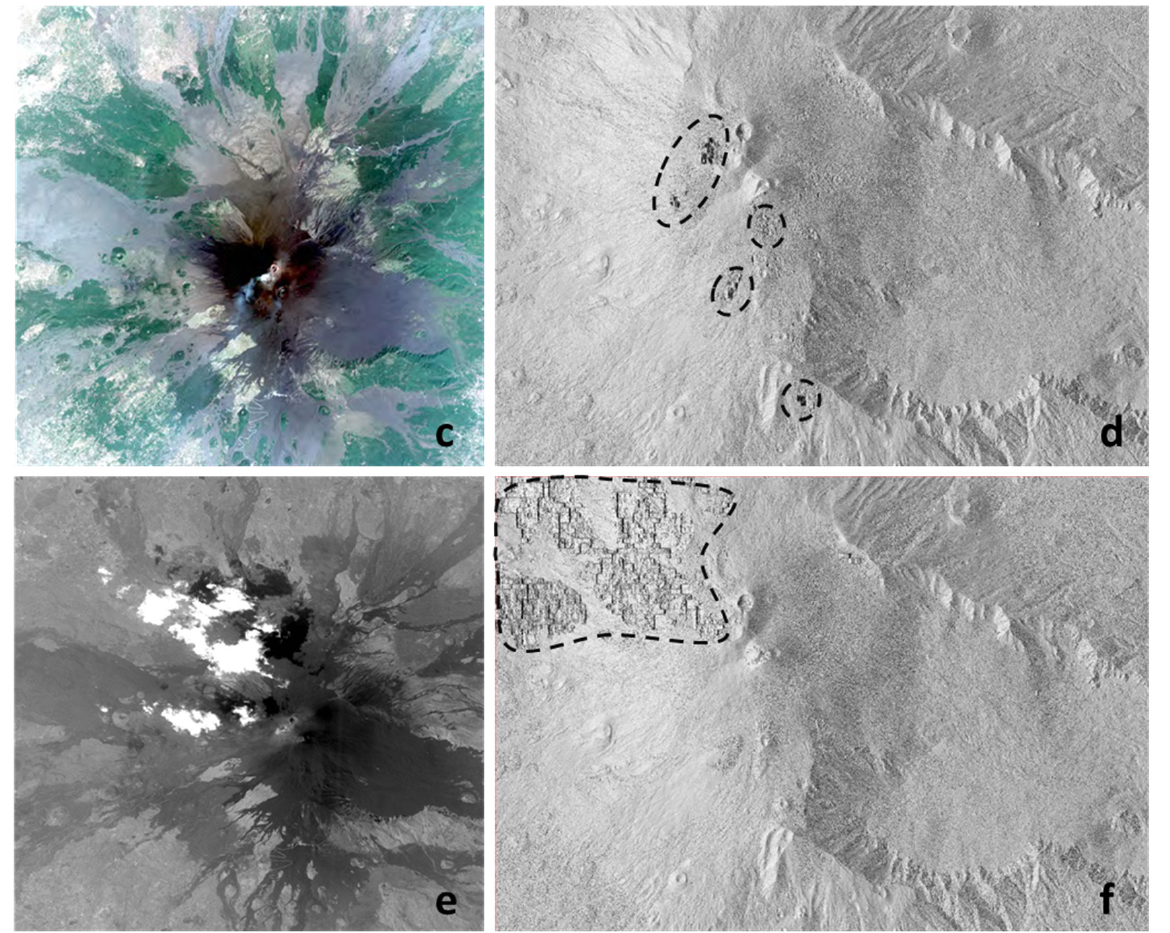
Figure 2. Pleiades images acquired on 13 ( a ) and 25 ( c ) July 2021 with the derived DSMs respec- tively ( b , d ). WorldView-1 scene of 27 July 2021 ( e ) and the derived DSM ( f ), with different false morphologies (dotted black areas).